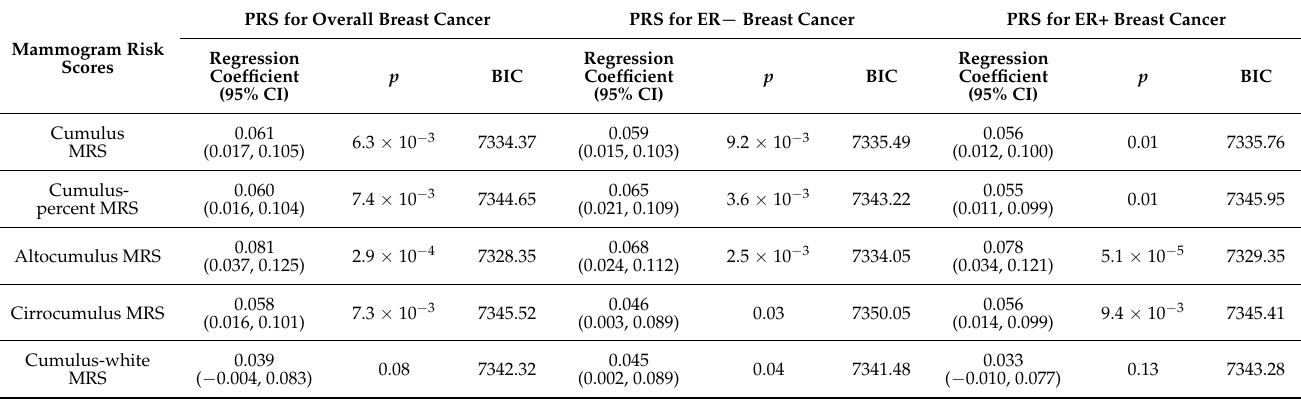
Table 3. Associations between mammogram risk scores and breast cancer polygenic risk